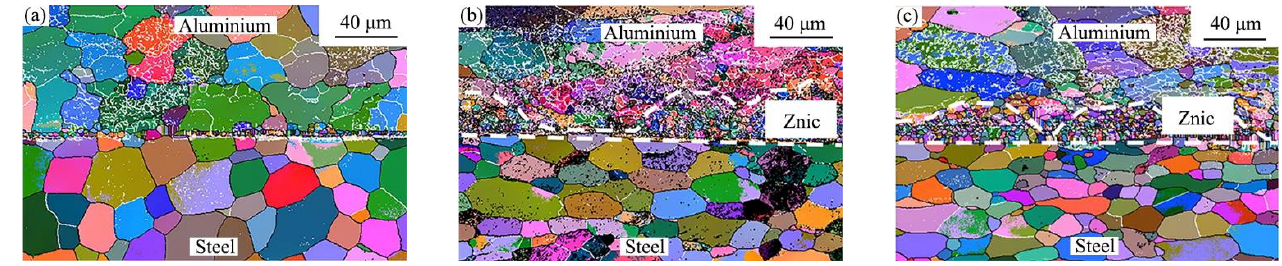
Figure 20. High magnification EBSD Euler contrast maps from the weld interface with a different combination [35]: ( a ) Al-to-DC04; ( b ) Al-to-DX56-Z; (c) Al-to-DX53-ZF. combination [35]: ( a ) Al-to-DC04; ( b ) Al-to-DX56-Z; (c)